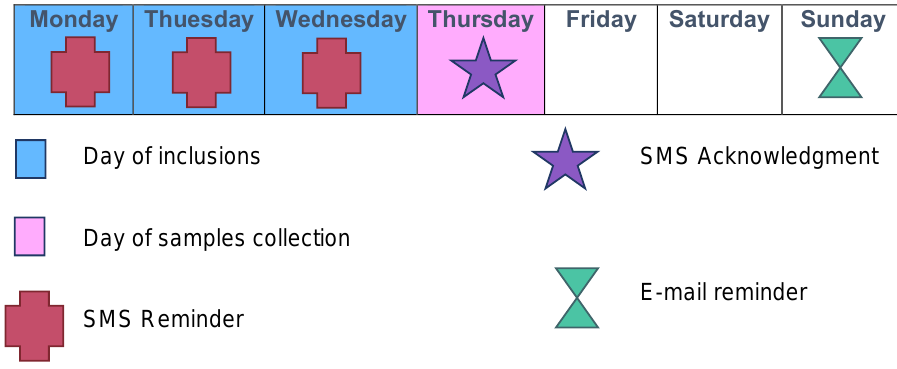
Figure 2. ECOVIR’s workflow.